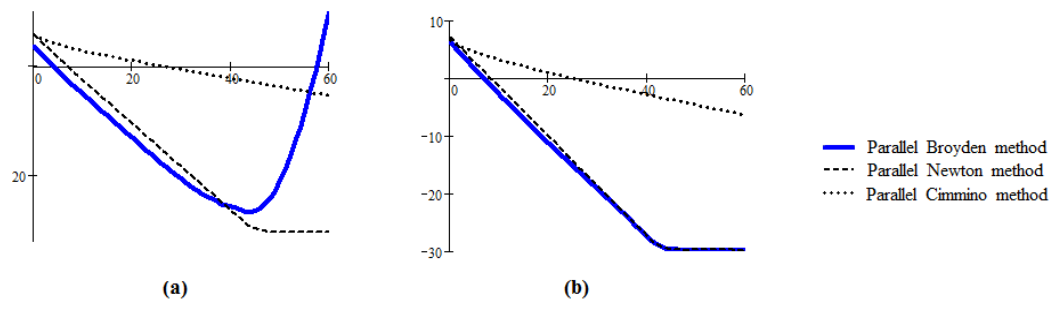
Figure 2. The behavior of the sequence generated by Algorithm 3, Parallel Newton method and Parallel Cimmino method (the graphs (a)) and by Algorithm 4, Parallel Newton method and Parallel Cimmino method (the graphs (b)); ( a ) system which does not satisfy the condition (2); ( b ) system well